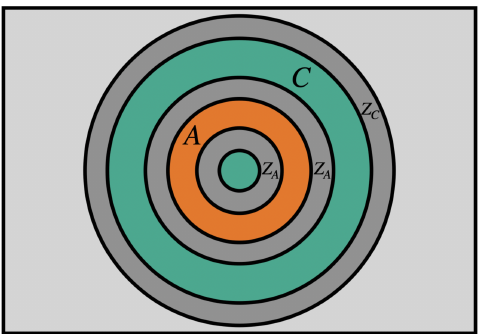
Figure 4 . A ball C with its buffer zone Z C . Inside we have a region A with buffer zone Z A . The complementary region to A inside C is called B . Region C cannot display generalized symmetries under the assumption of Haag duality. Regions A and B might display generalized symmetries. When the classes associated with the generalized symmetry are charged under the global symmetry group additive twists in A and B cannot concatenate to twists in C